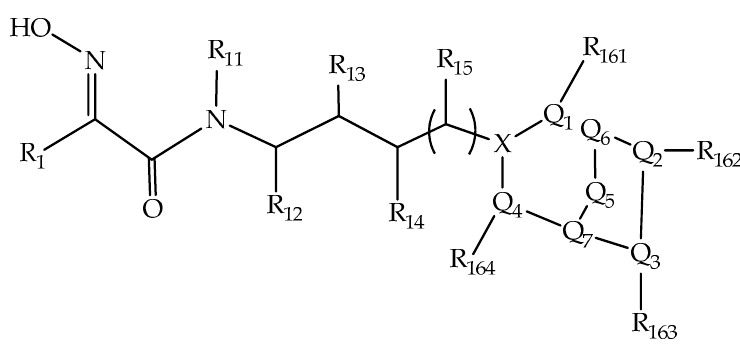
Figure 19. Formula III of an oxime developed in the patent [90].